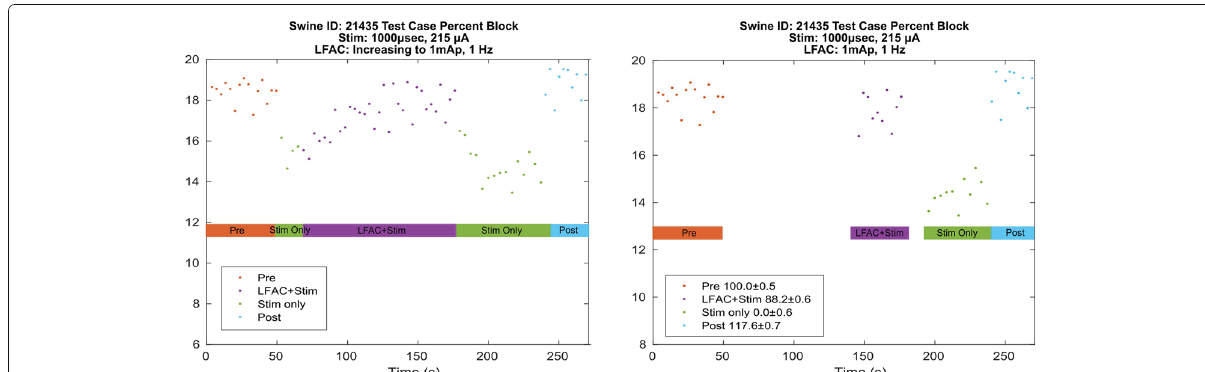
Fig. 7 Test case of Swine ID 21435. In this unconventional case, the test sequence was applied out of order. Following a baseline reading, the HB reflex was established. The amplitude of the LFAC waveform was then slowly ramped up until block was achieved. The LFAC waveform was then discontinued which resulted in the activation of the HB reflex almost instantly. The left panel shows the unconventional test sequence order. To quantify the percent block ( ± SD), 4 epochs were isolated, shown on the right panel: Pre, LFAC+Stim, Stim Only, and Post. The ’LFAC+Stim’ epoch had a max amplitude of 1 mA p applied at 1 Hz , thus the window of ’LFAC+Stim’ was determined based on the location of the max